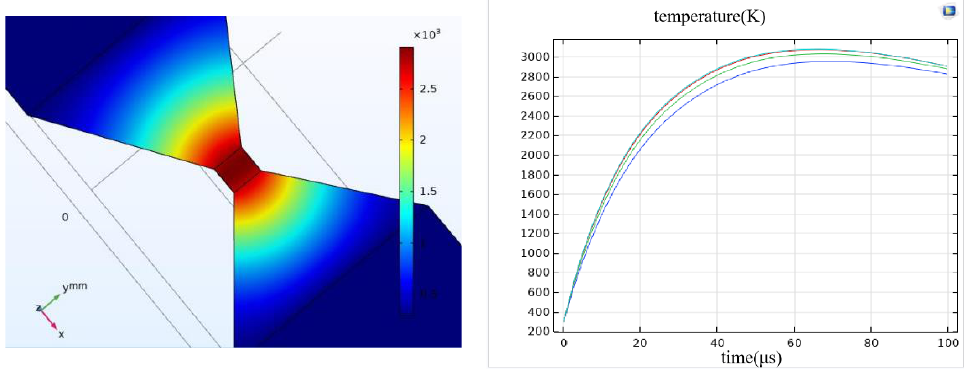
Figure 9. Solid-state ON–OFF switch controls the temperature rise curve of bridge area with time.